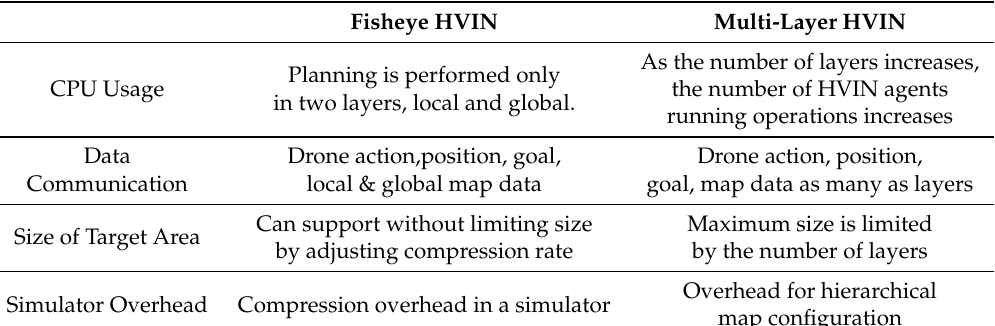
Table 4. Fisheye HVIN vs. Multi-Layer